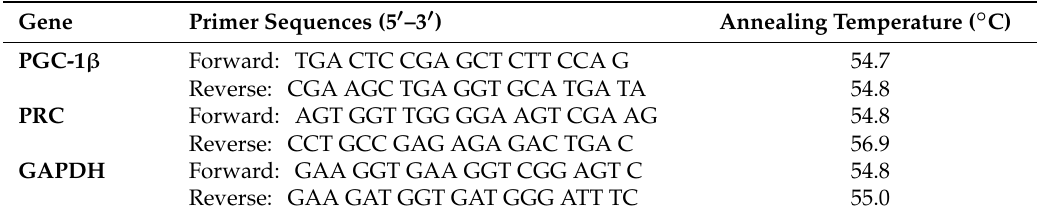
Table 1. Sequence of primers for real-time